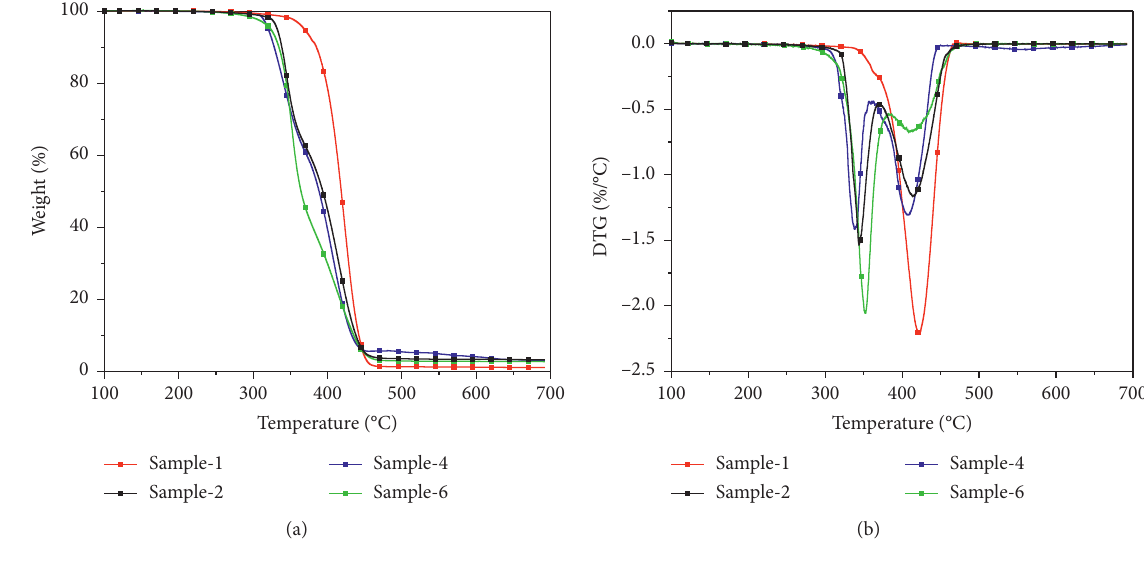
Figure 6: TGA (a) and DTG (b) curves of HIPS samples.